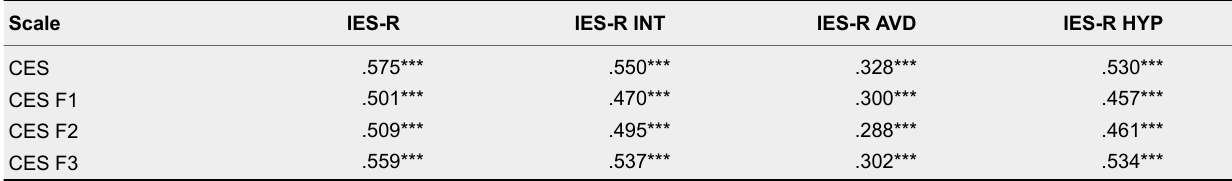
Correlation Among CES and